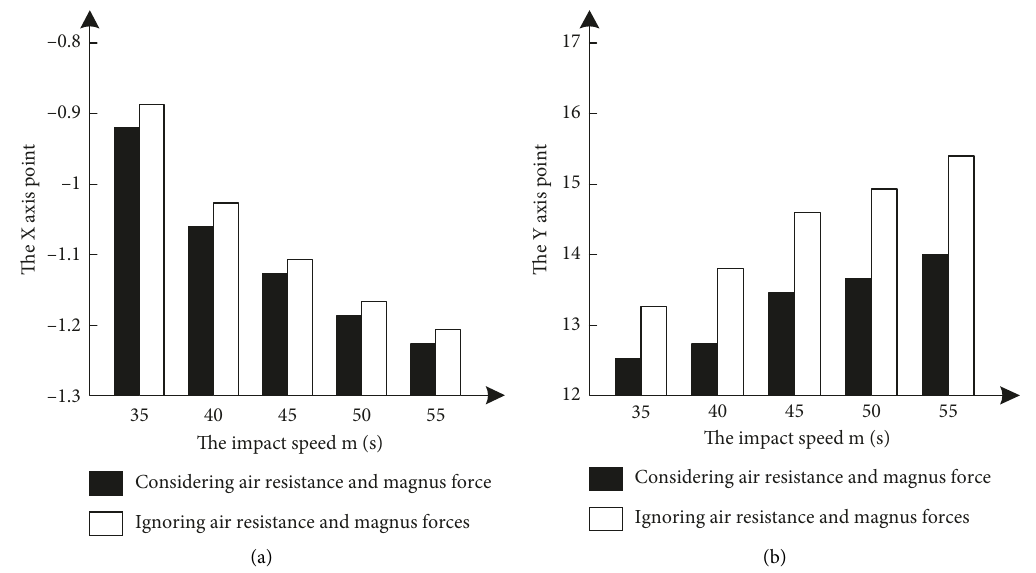
Figure 6: Relationship between the impact velocity of a tennis ball and the coordinates of its landing point: (a) x -coordinate and (b) y -coordinate. Table 5: Simulation parameters without impact angle.